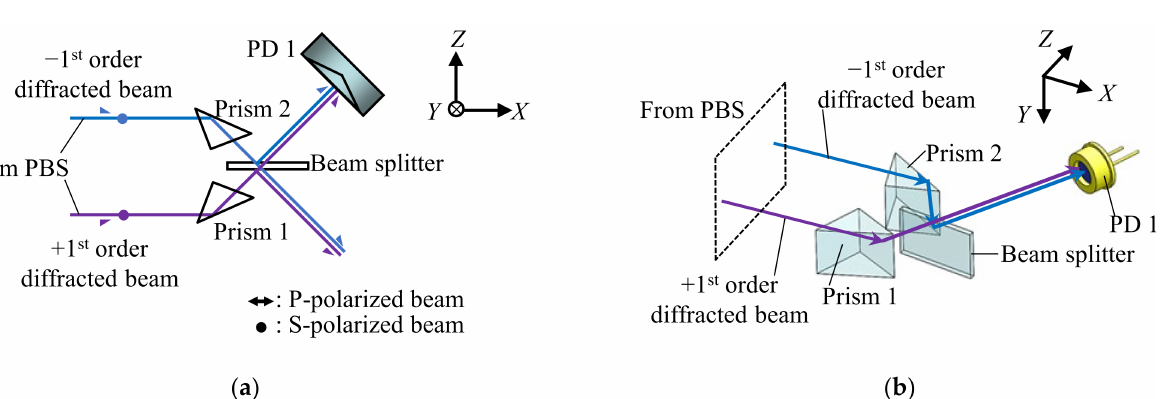
Figure 2. The optical design of ∆ x -assembly: ( a ) XZ view; ( b ) three-dimensional